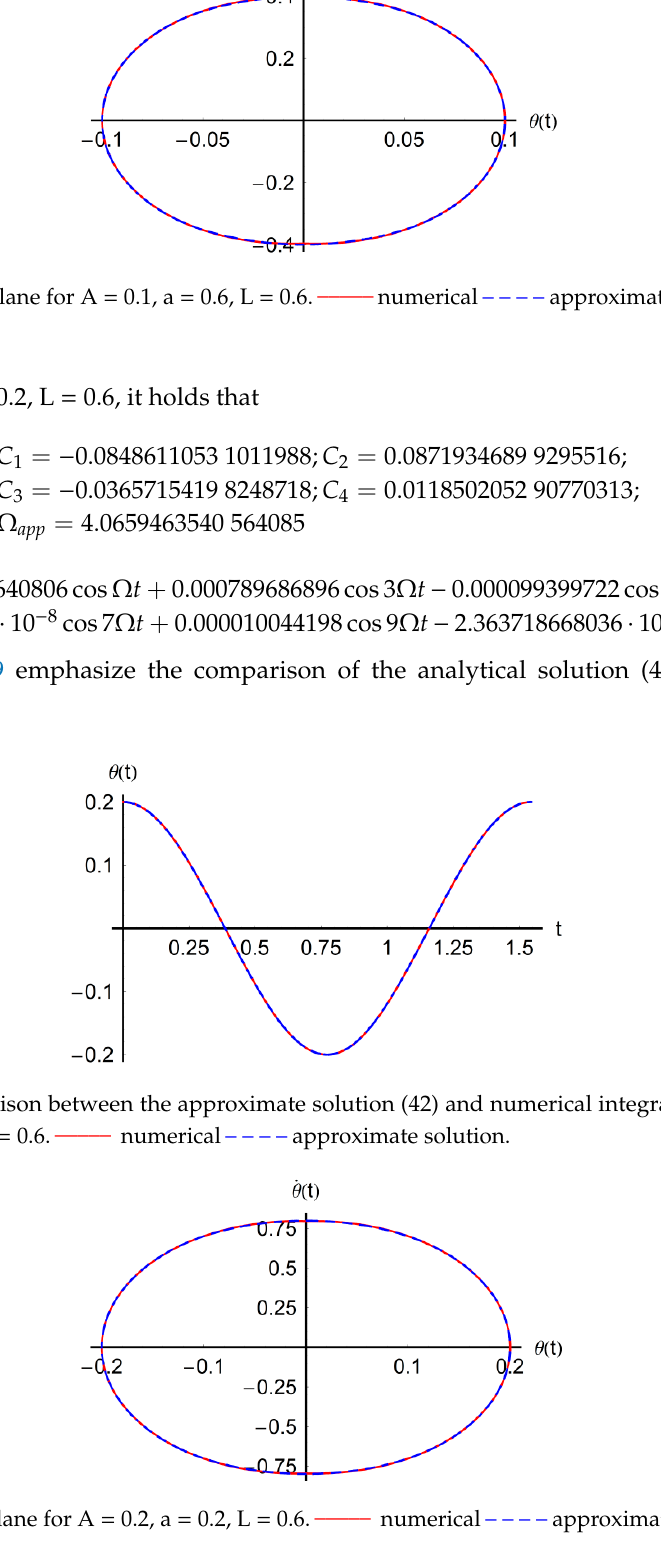
Figure 21. Phase plane for A = 0.4, L = 0.6. Figure 9. Phase plane for A = 0.2, a = 0.2, L = 0.6. _____ numerical_ _ _ _approximate solution (42). Figure 9. Phase plane for A = 0.2, a = 0.2, L = 0.6.